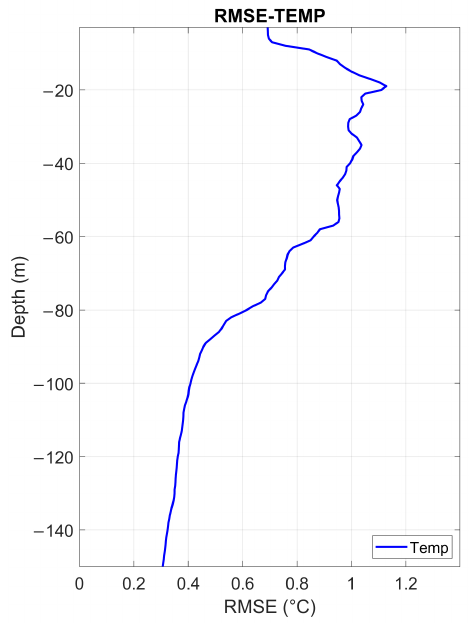
Figure 7. Temperature RMSE profile computed on the test set as a function of